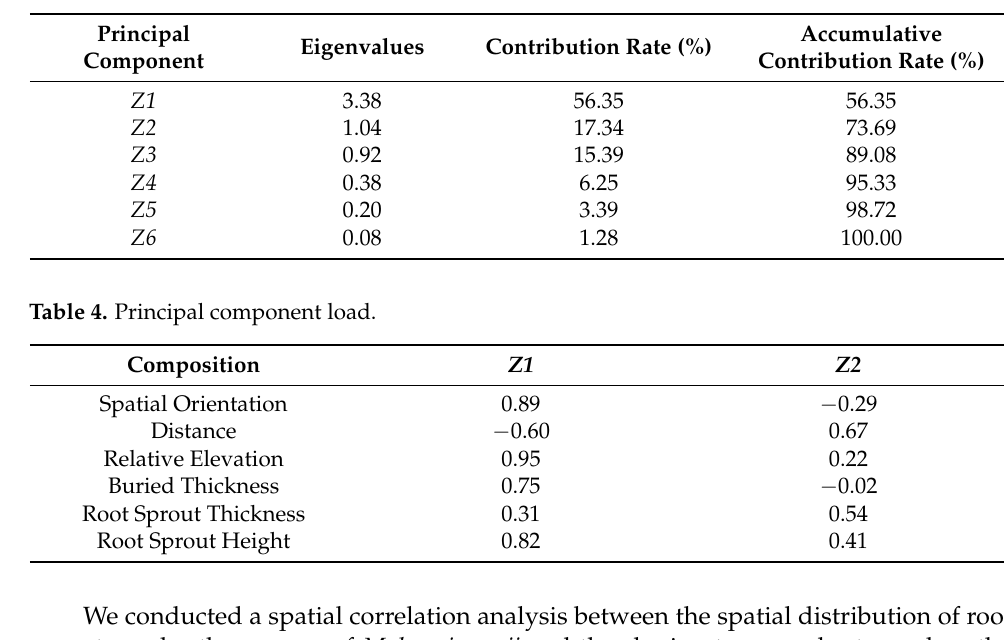
Table 3. Eigenvalue and contribution rate.